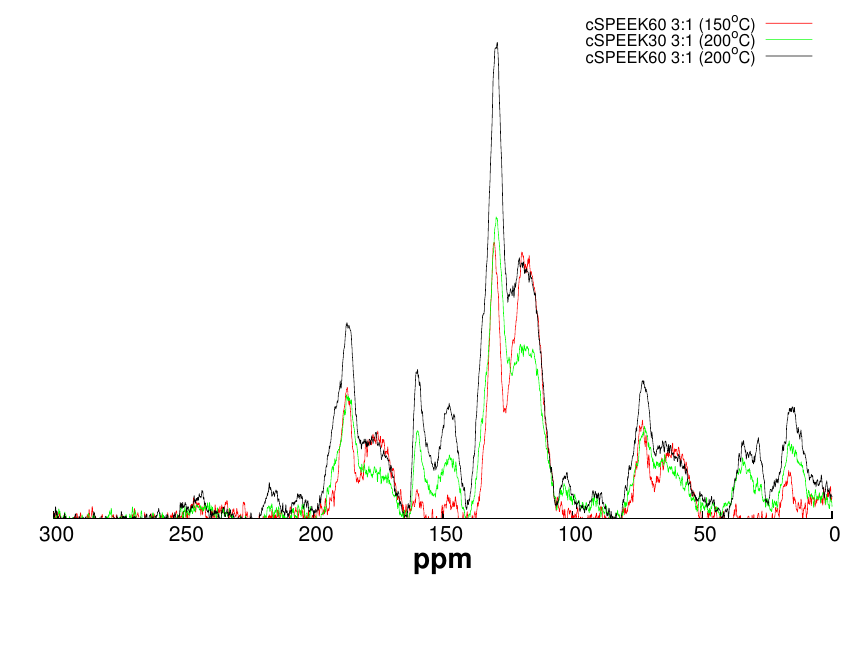
Figure A1. Solid State C 13 -NMR of crosslinked SPEEK membranes. Sample code: cSPEEK60 3:1 = crosslinked SPEEK with a crosslinking time of 60 min and a SPEEK:crosslinking ratio of